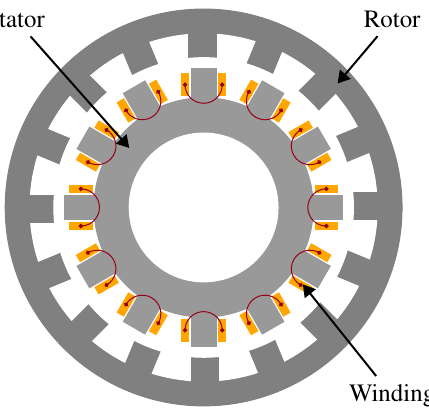
Figure 6. Topology of an outer-rotor switched reluctance